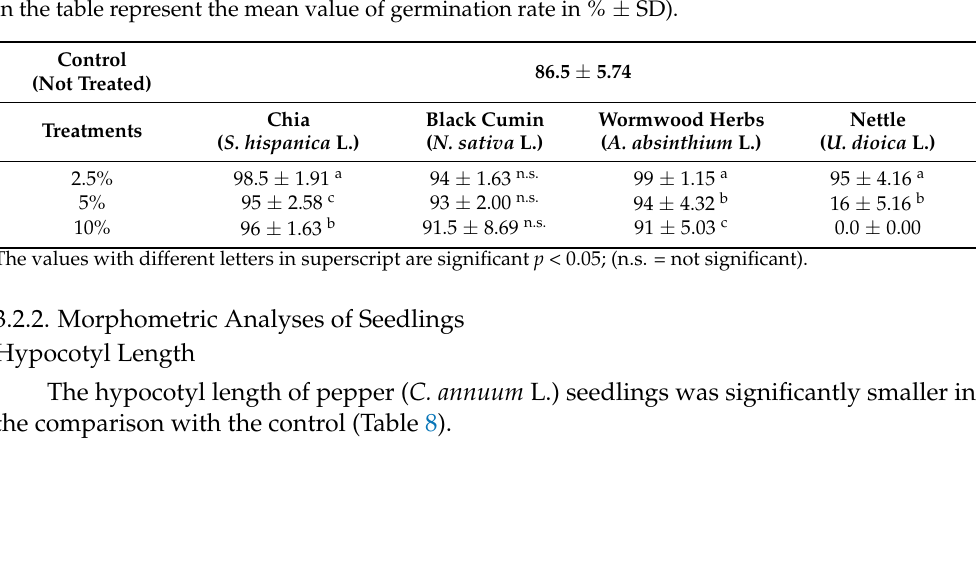
Table 7. Comparison of differences of means for lettuce seeds germination ( L. sativa L.) (The values in the table represent the mean value of germination rate in % ± SD). Control (Not Treated)